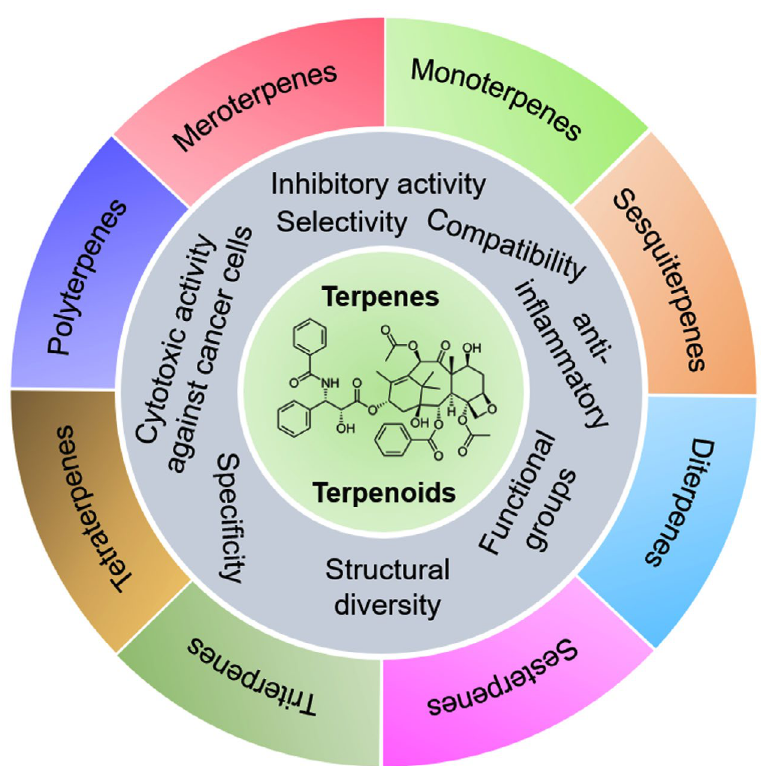
Fig. 1. Categories of terpenoids based on the number of carbon units and their